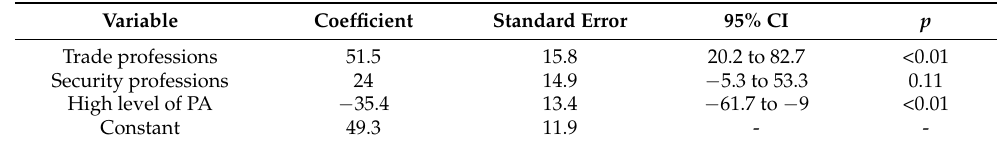
Table 5. Multiple linear regression adjusted for gender, tobacco use, alcohol consumption and type of